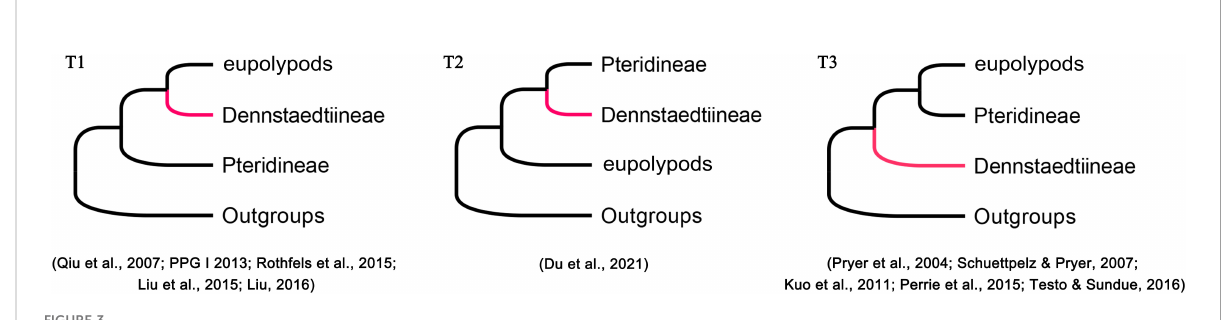
FIGURE 3 Phylogenetic position of Dennstaedtiineae among the polypod ferns suggested in the previous